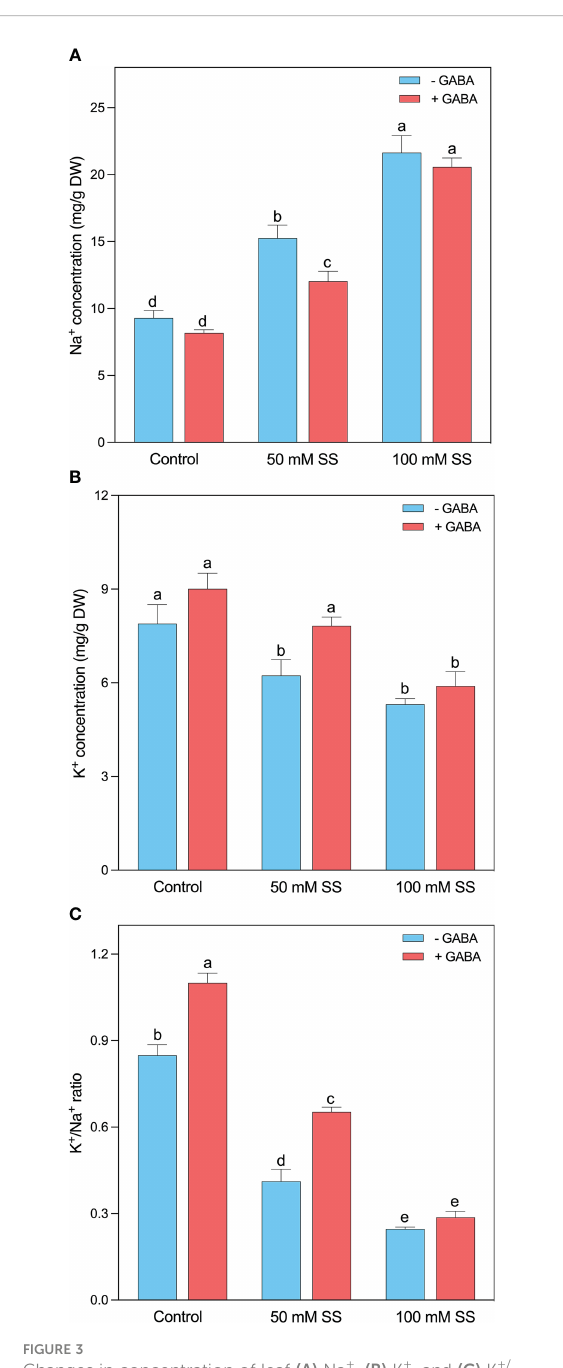
FIGURE 3 Changes in concentration of leaf (A) Na + , (B) K + , and (C) K +/ Na + ratio and root (f) Na + , (g) Cl - (h) K + (i) Mg ++ and (i) K +/ Na + ratio of mungbean plants under saline stress (SS) and exogenous ( g -aminobutyric acid) treatments. The bars indicate the SE of the mean value, n=3. Different letters above the bars indicate signi fi cantly different values at P <0.05 following Duncan ’ s